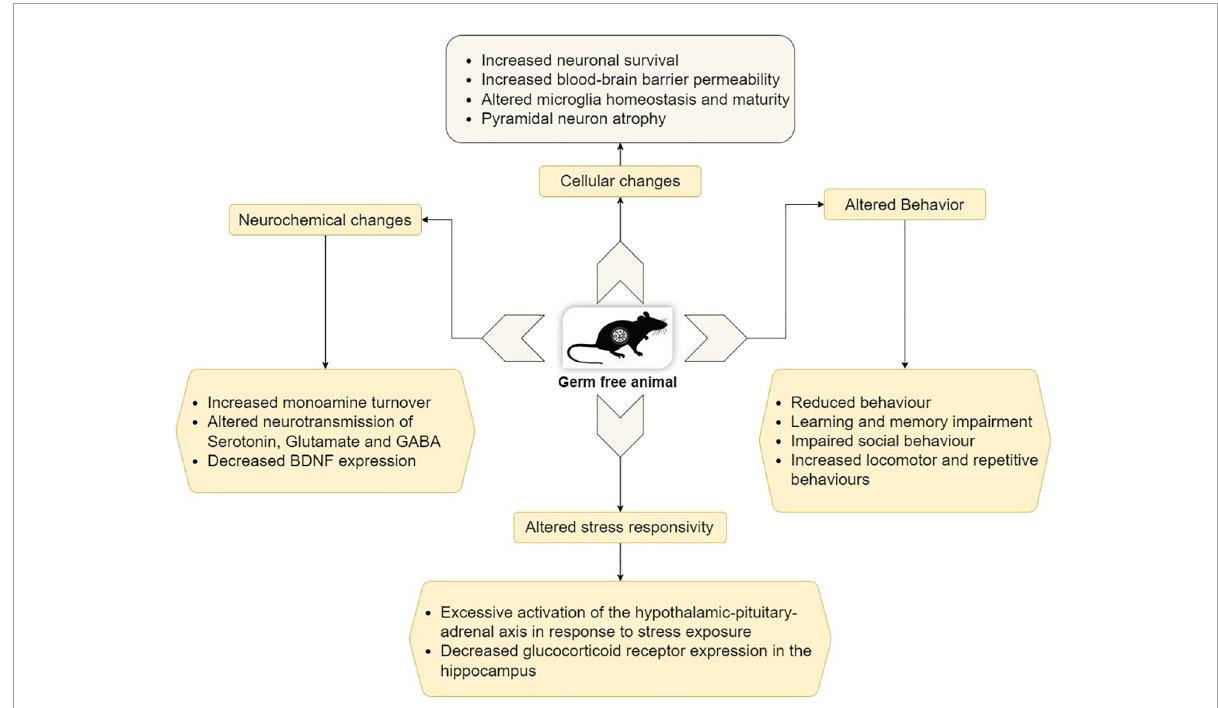
FIGURE2 Behavioral, molecular, cellular, and neurochemical changes in GF animals (Modified from Socała et al.,